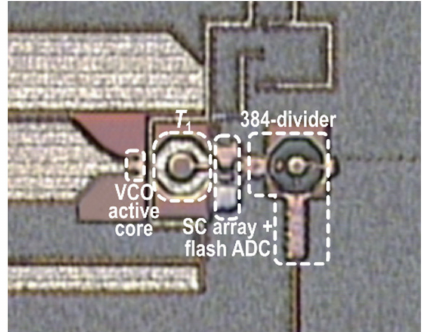
Figure 5. Die microphotograph.